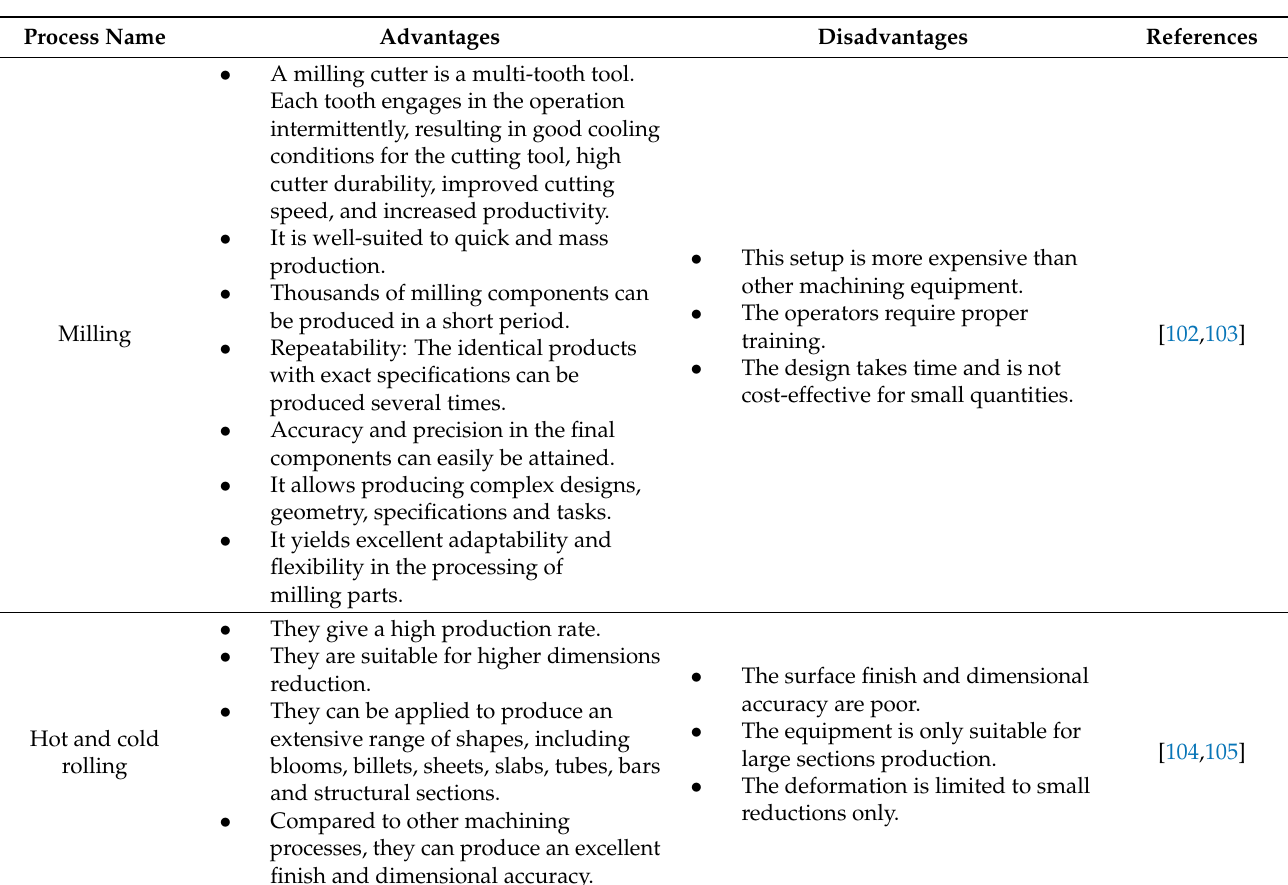
Table 1. Advantages and disadvantages of conventional machining